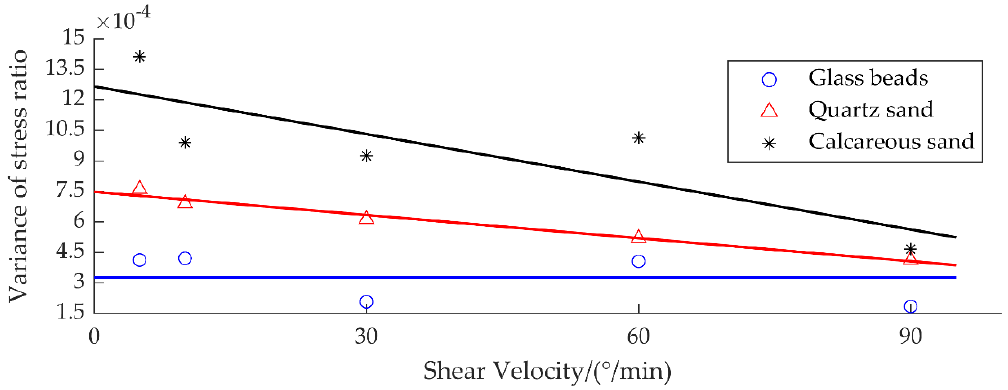
Figure 9. Relation of the variance of the stress ratio and the shear rate for different particle systems.